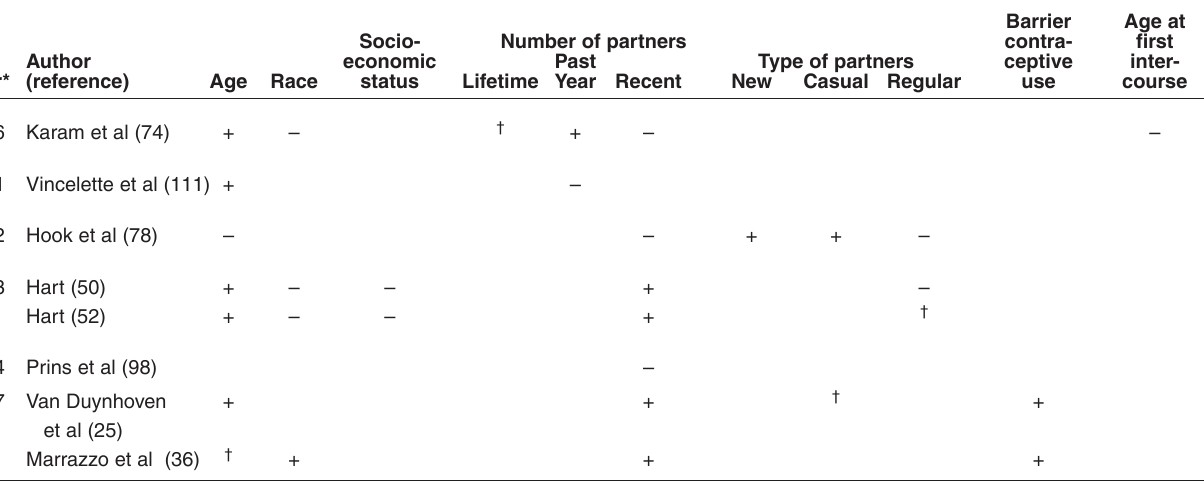
TABLE 4 Risk factors for chlamydia in